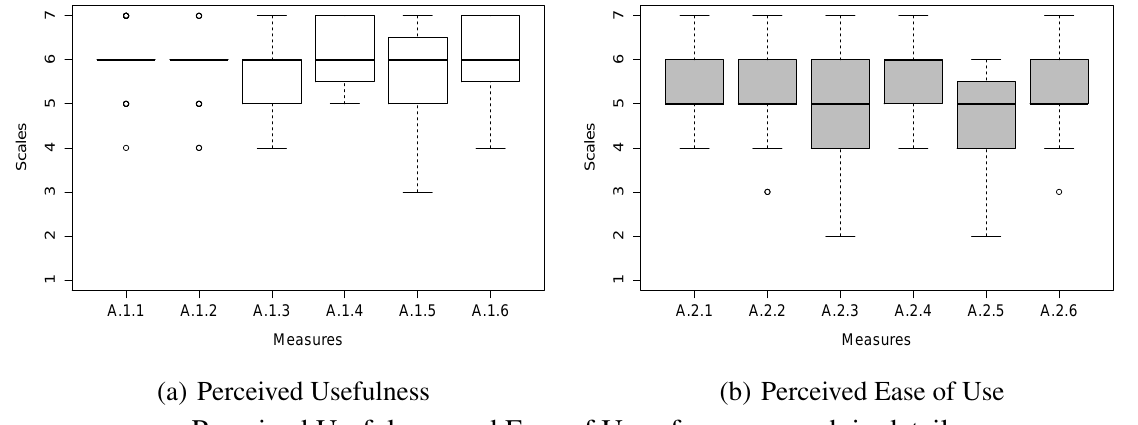
(b) Perceived Ease of